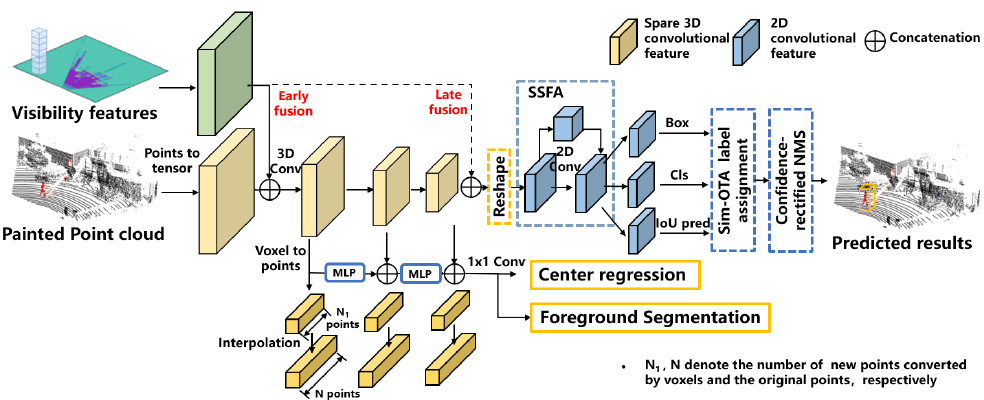
Figure 2. The pipeline of our proposed anchor-free 3D single-stage object detection network with supervised-PointRendering and spatial visibility